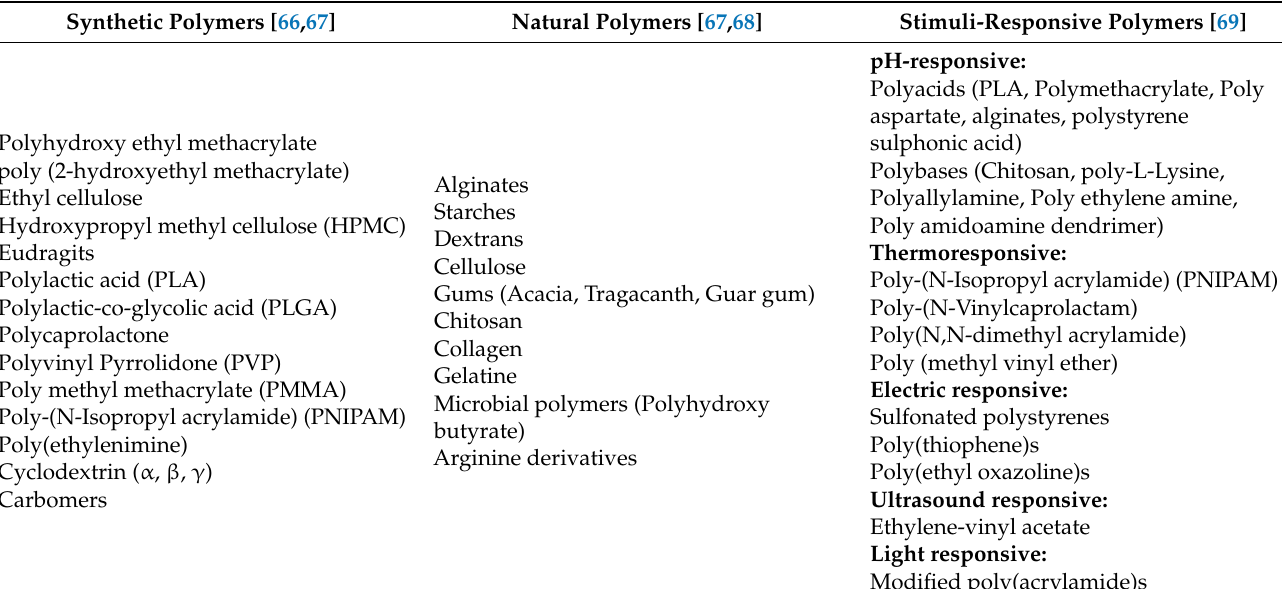
Table 8. Polymers used in the development of controlled release drug delivery systems. Synthetic Polymers [66,67] Natural Polymers